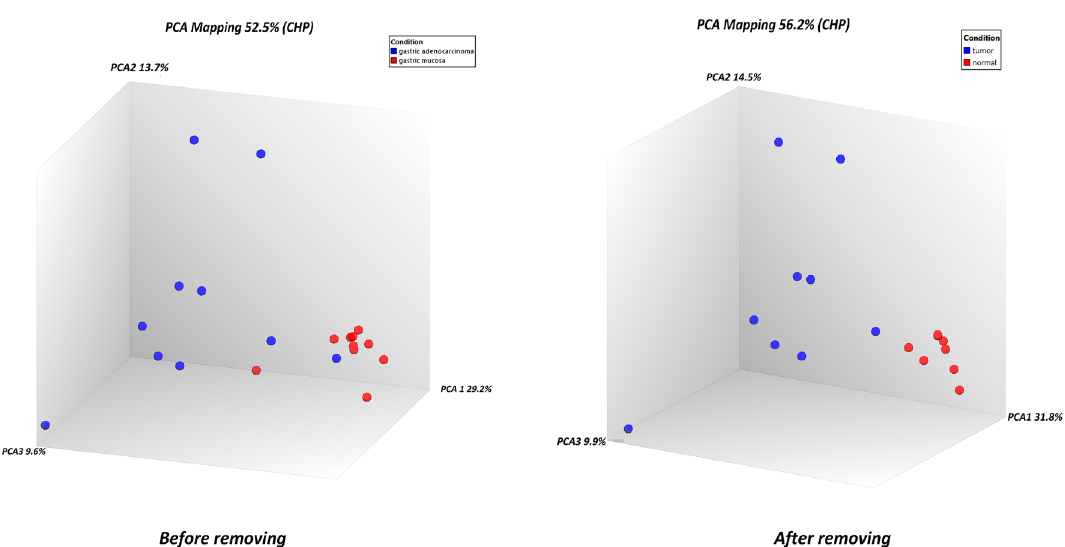
Figure 3. The PCA graph of gastric adenocarcinoma samples versus paired normal tissues before and after removing two outlier samples. Normal patients and tumor patintes are well separated on principal component 1 (PCA1). Note: Red dots are normal samples, and blue dots are tumor tissue